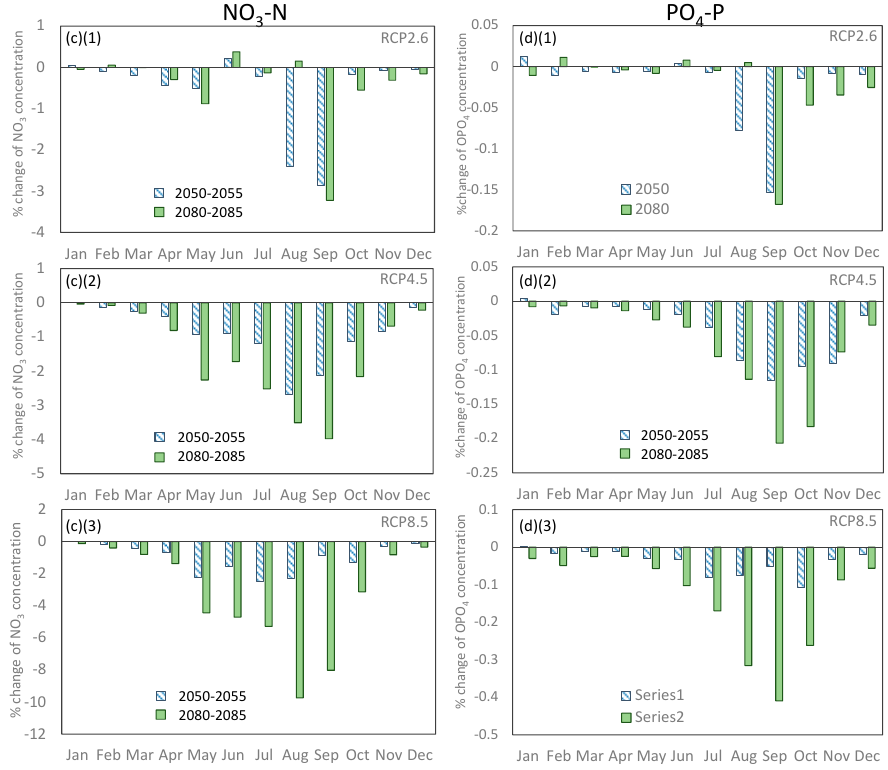
Figure 11. Percent change in water quality parameter concentrations for NO 3 -N, and PO 4 -P due to climate change scenarios ( 1 ) RCP 2.6; ( 2 ) RCP 4.5; and ( 3 ) RCP 8.5 at the Tugaske location.